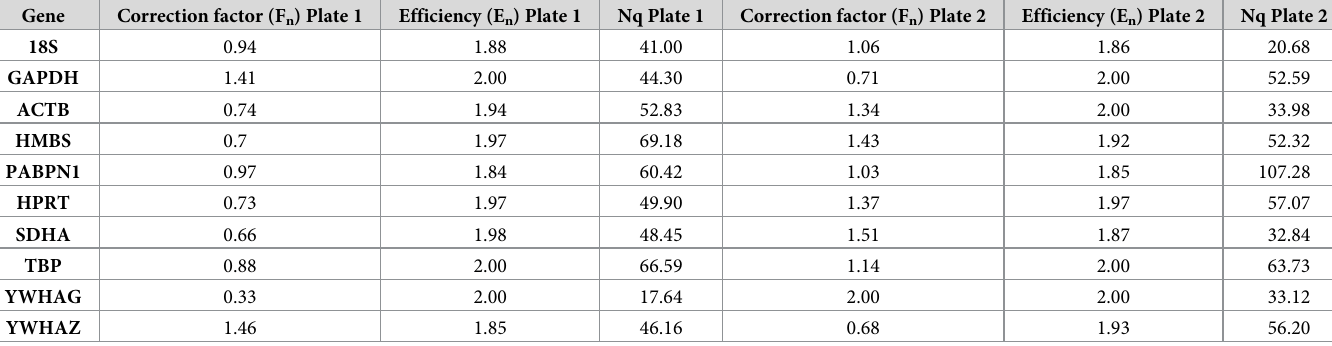
Table 3. Correction factors, plate specific efficiencies and quantification threshold.